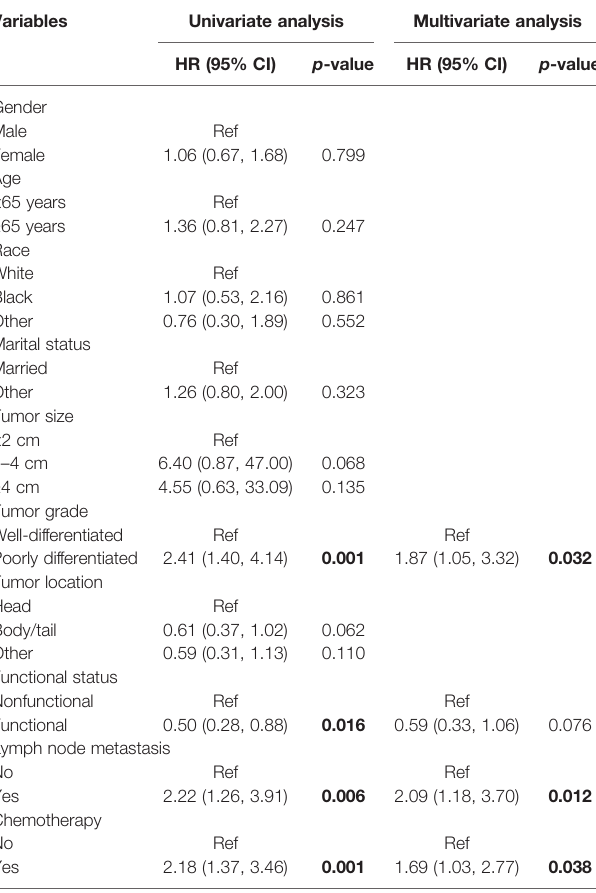
TABLE 3 | Univariate and multivariate analyses of OS in patients who underwent